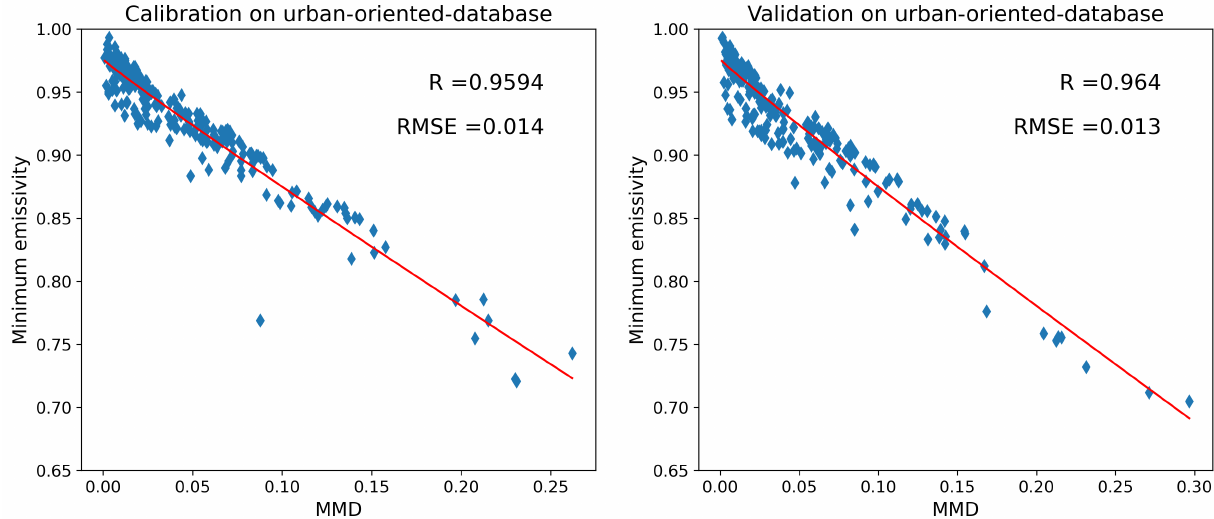
Figure 7. MMD relationship statistical fits for the 1MMD TES with the urban-oriented database: calibration ( left ) and validation ( right ). The obtained MMD relationship is highlighted with a red